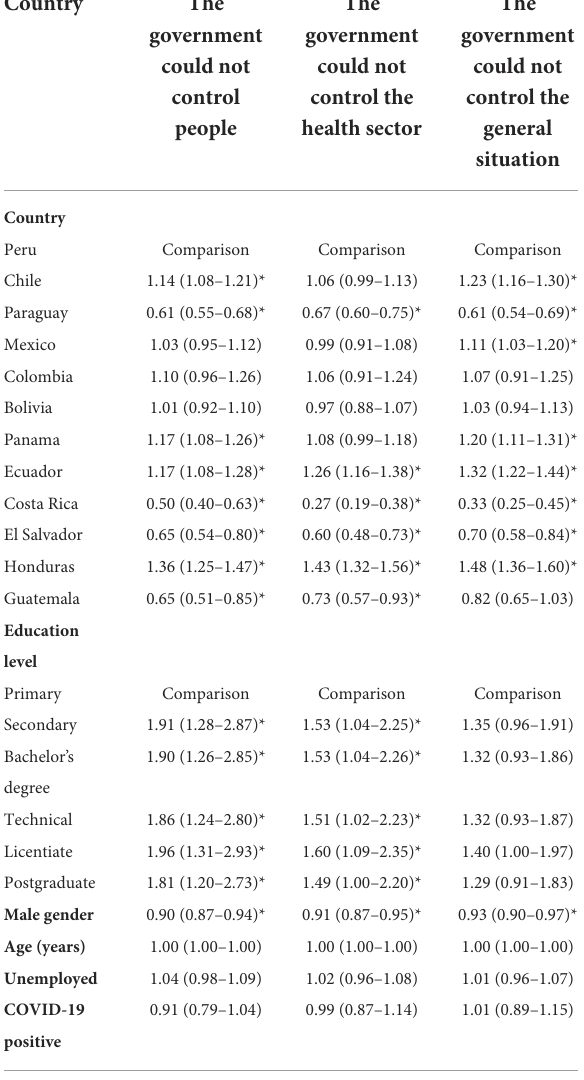
TABLE 4 Multivariate analytical statistics of the mechanism of inadequate control that 12 Latin American governments had in three aspects during the first wave of the COVID-19